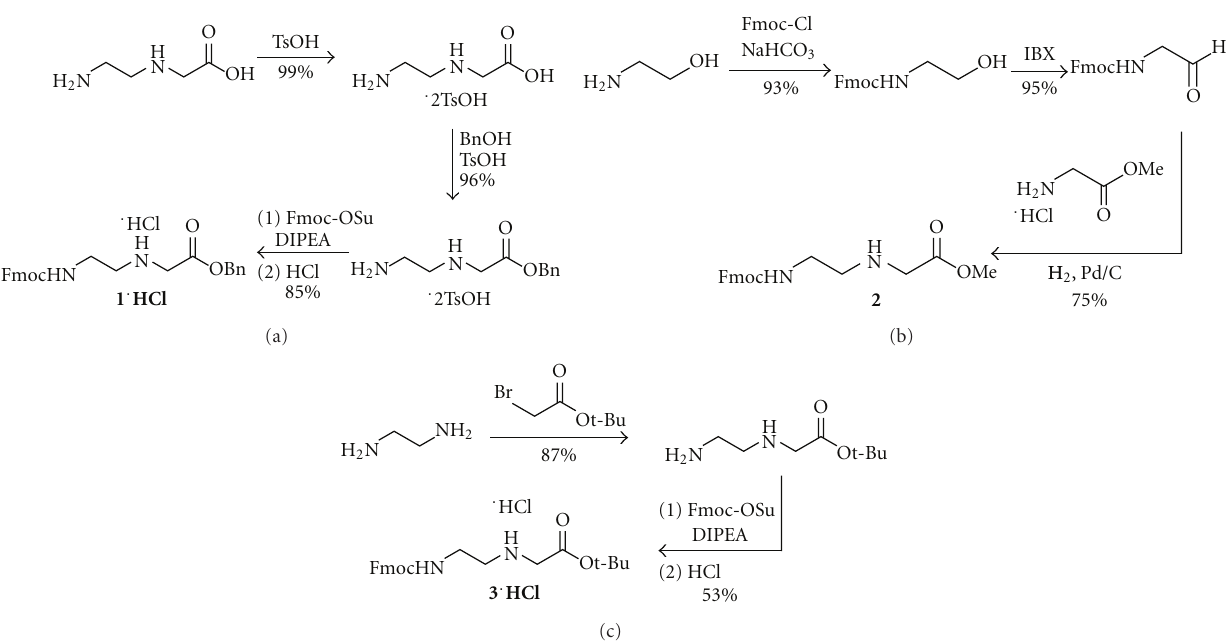
Figure 3: Reported synthetic routes to the Fmoc-AEG-OR